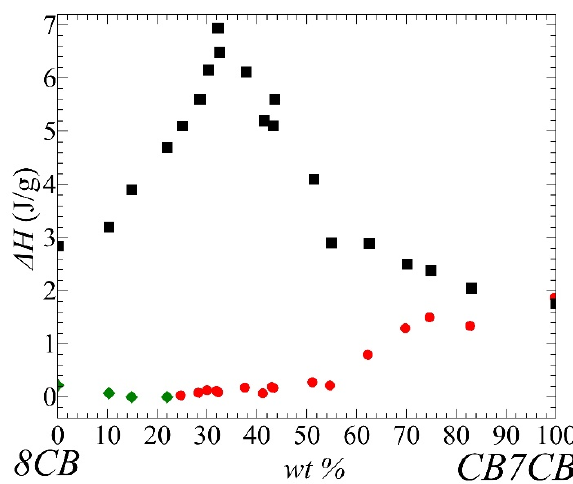
Figure 5. Enthalpy of phase transitions as a function of CB7CB concentration. Black squares correspond to the Iso / N phase transition, red disks to the N / N TB phase transition, and green diamonds to the N / SmA phase transition.